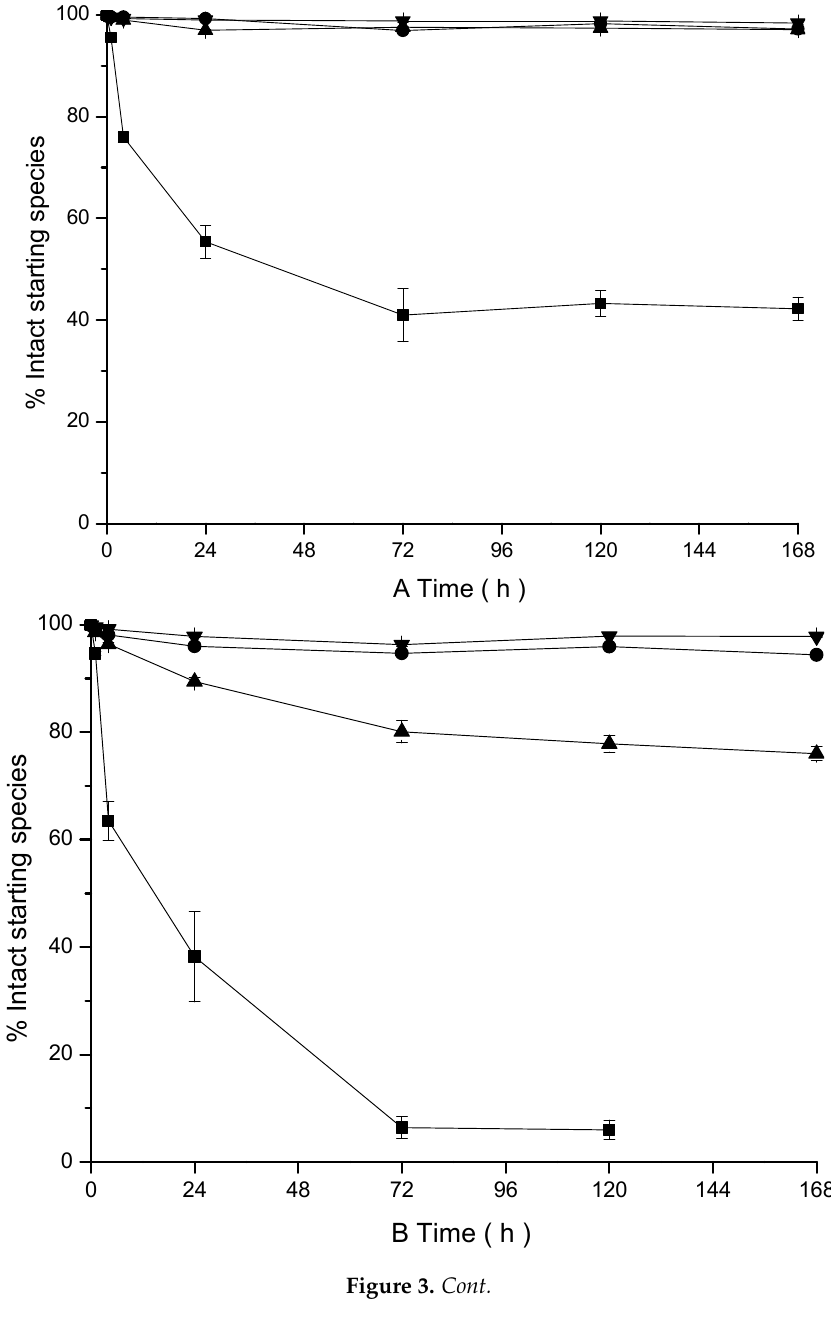
Figure 3A. At pH 6, [ 89 Zr]Zr-FSC(succ) 3 remained intact (97.8%), being more stable than [ 89 Zr]Zr- TAFC (94.4%) and significantly higher than [ 89 Zr]Zr-FSC(succ) 2 AA (76%), see Figure 3B. At pH 4, the difference in stability of [ 89 Zr]Zr-FSC(succ) 3 and [ 89 Zr]Zr-TAFC was more pronounced (87.9 vs. 70.3% of intact complex, respectively, at day 7), see Figure 3C.